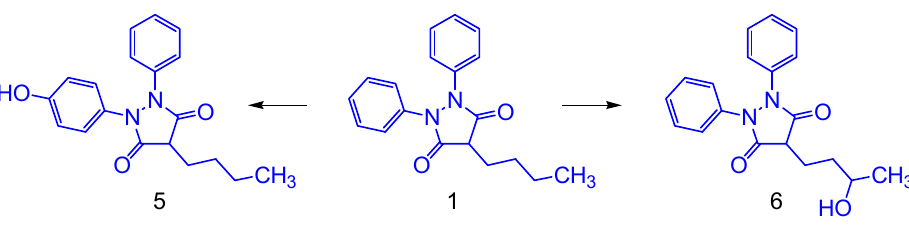
Figure 3. Molecular metabolism of phenylbutazone.